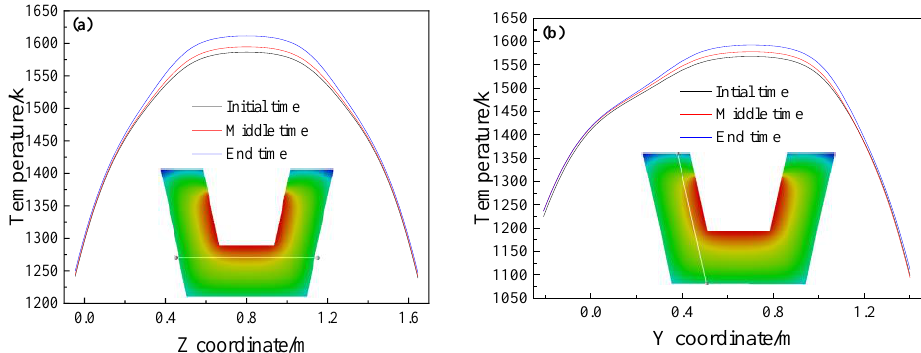
Figure 7. Refractory temperature of the main trough at different positions during tapping: ( a ) X = 4 m, Y = 0.35 m; ( b ) X = 4 m, Z = 0.4 m.